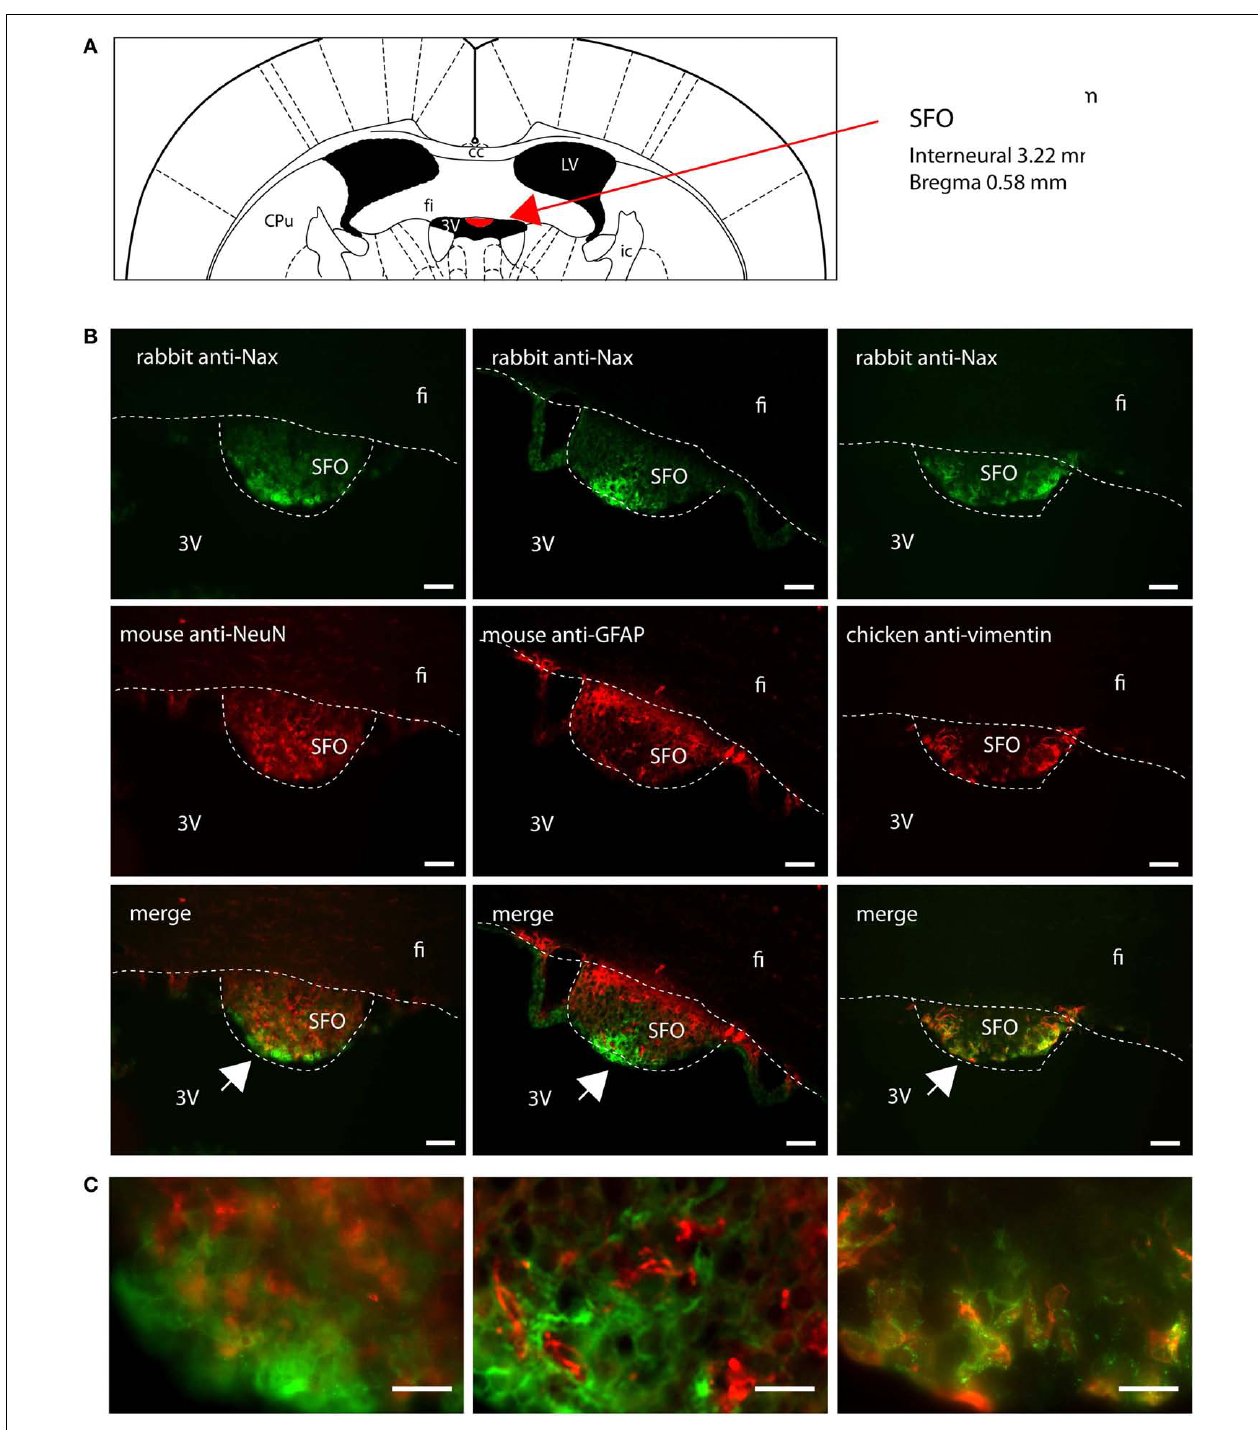
expressing Na X was identified using anti-NeuN, anti-GFAP, and anti-vimentin fluorescent immunostaining (red); scale bars: 50 µ m. (C) Inset representing high magnification zone of the SFO; scale bar: 20 µ m.The detailed zone is pointed by the arrow head (bottom-left corner of the inset). Na X staining is only present in the vimentin positive cells boarding the third